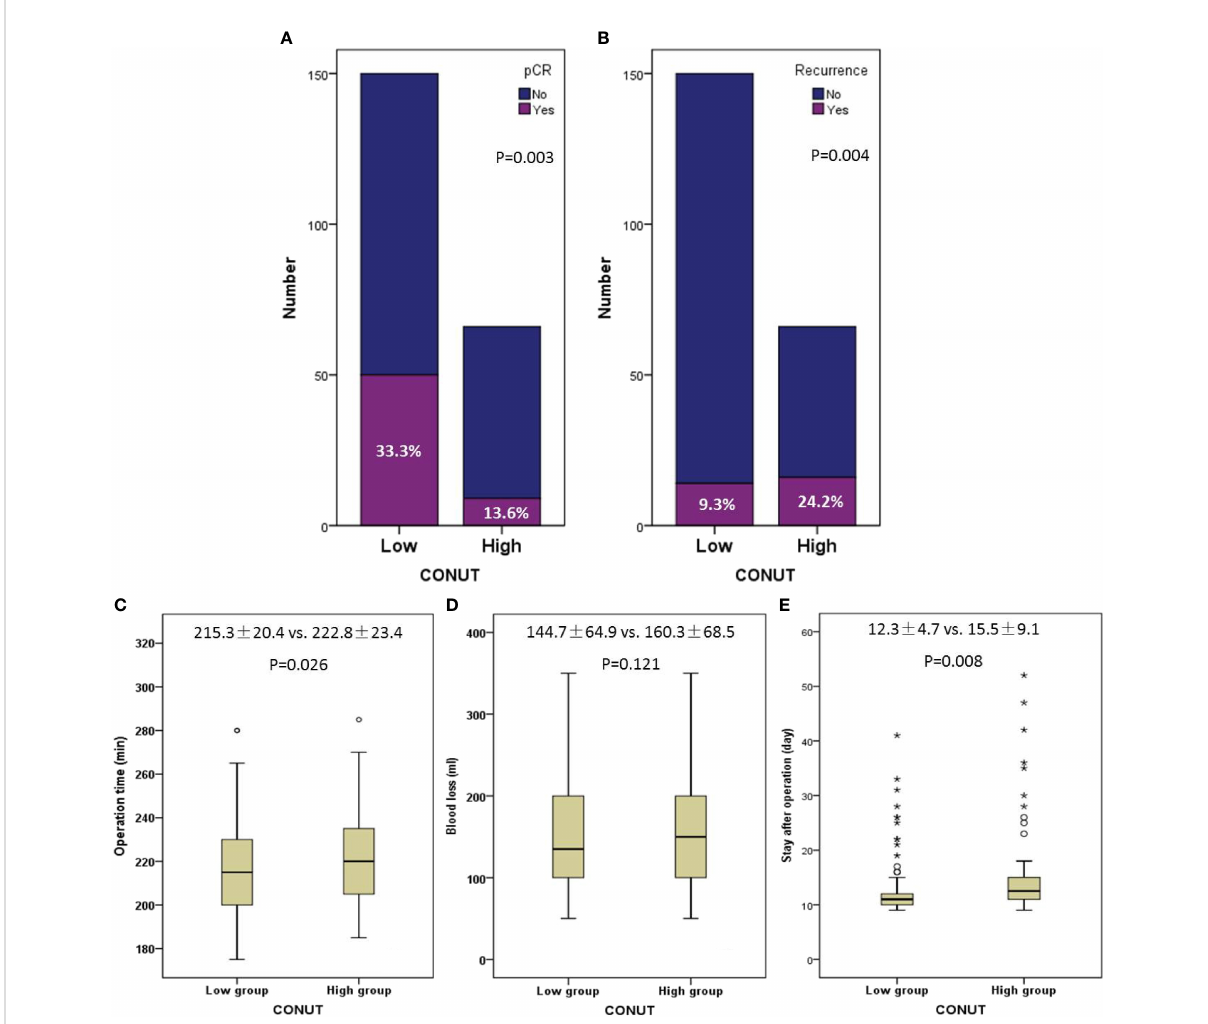
FIGURE 4 Comparisons of pathologic complete response (33.1% vs . 13.8%, P = 0.004) (A) and recurrence (24.6% vs. 9.3%, P = 0.003) (B) grouped by CONUT. Correlations between CONUT and operation time ( P = 0.026) (C) , blood loss ( P = 0.141) (D) , and hospital stay after operation ( P = 0.008) (E) . The symbols of “ *, O ” mean abnormal